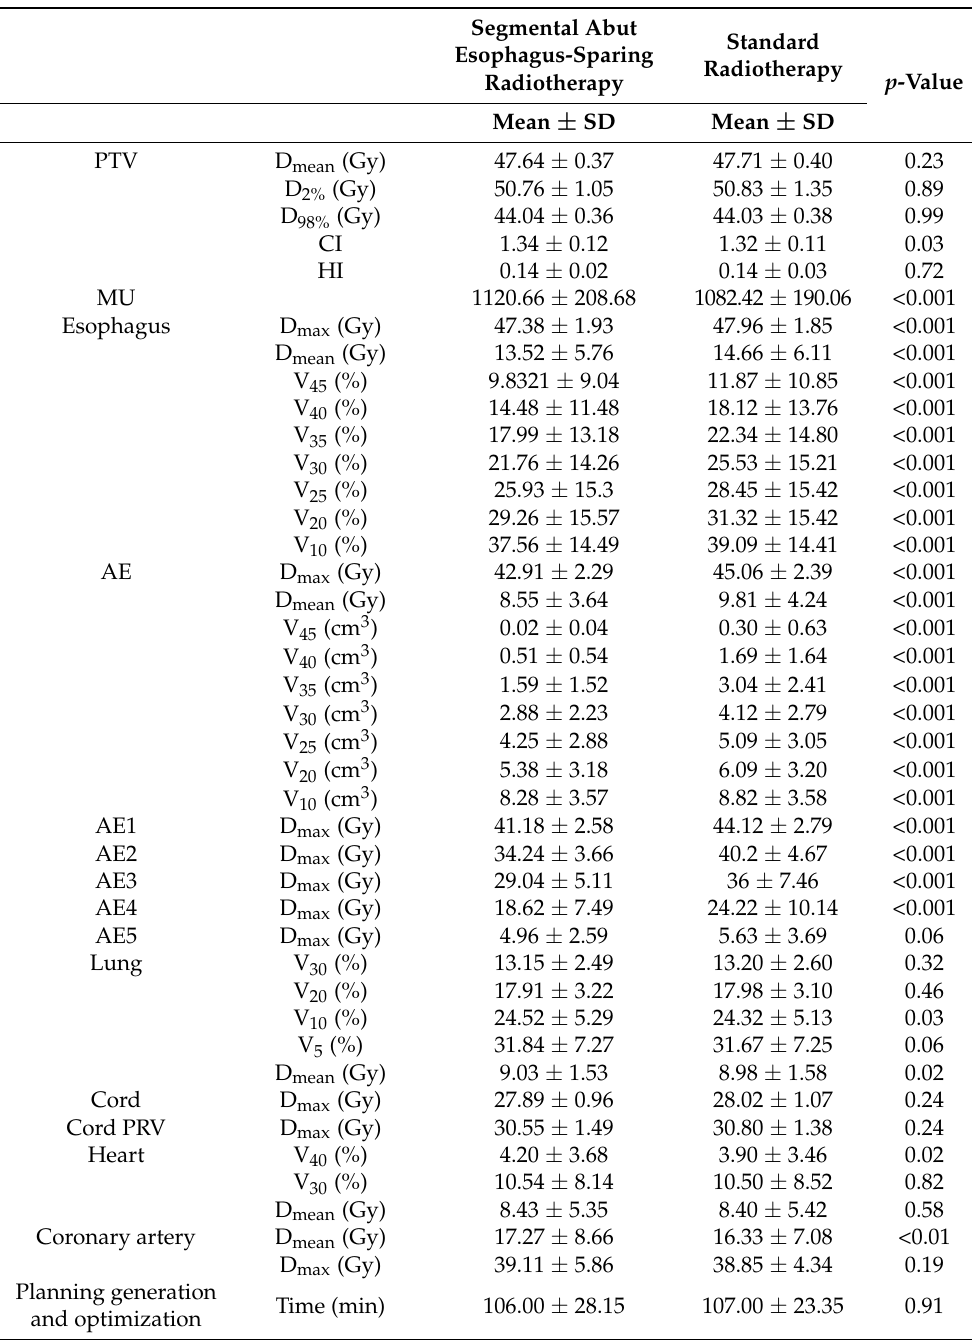
Table 2. Dose–volume histogram parameters between segmental free esophagus-sparing technique and standard radiotherapy.